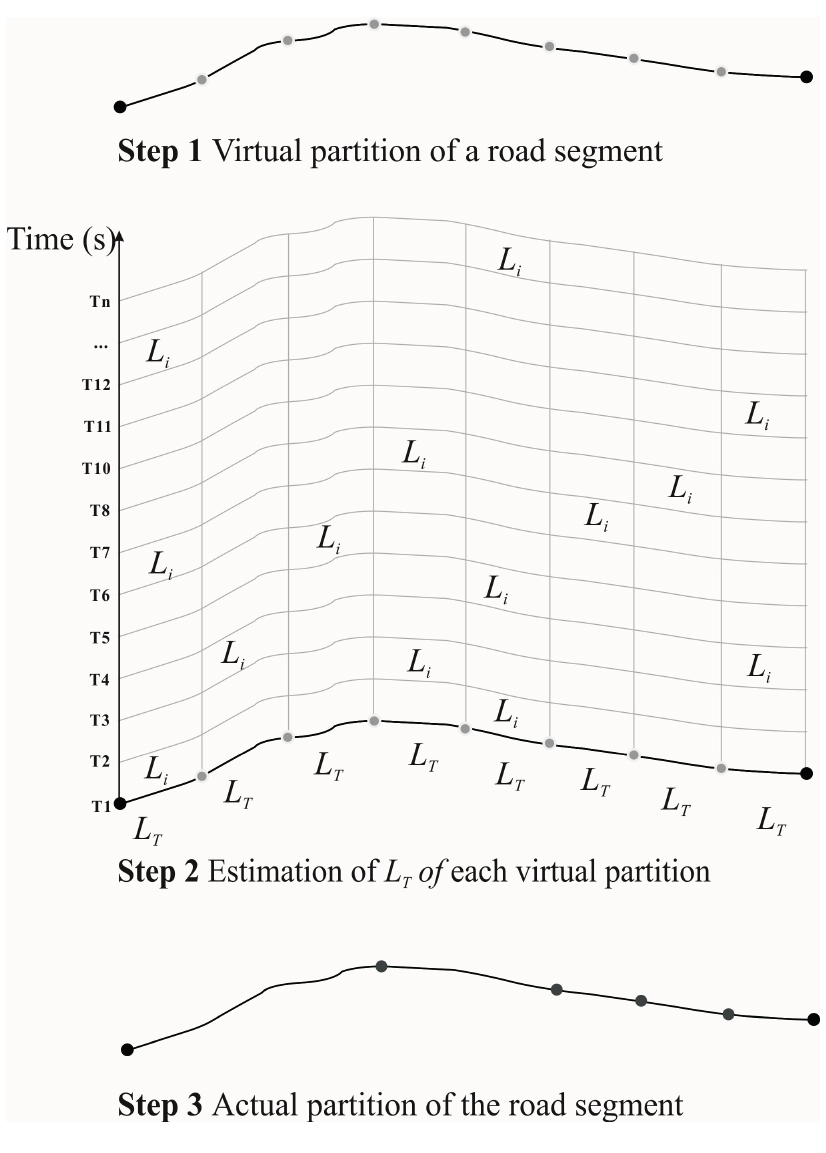
Figure 3. The process of dynamic estimation of noise levels at multi-temporal scales. Stage III: Dynamic Segmentation of Road Segments in Different Time